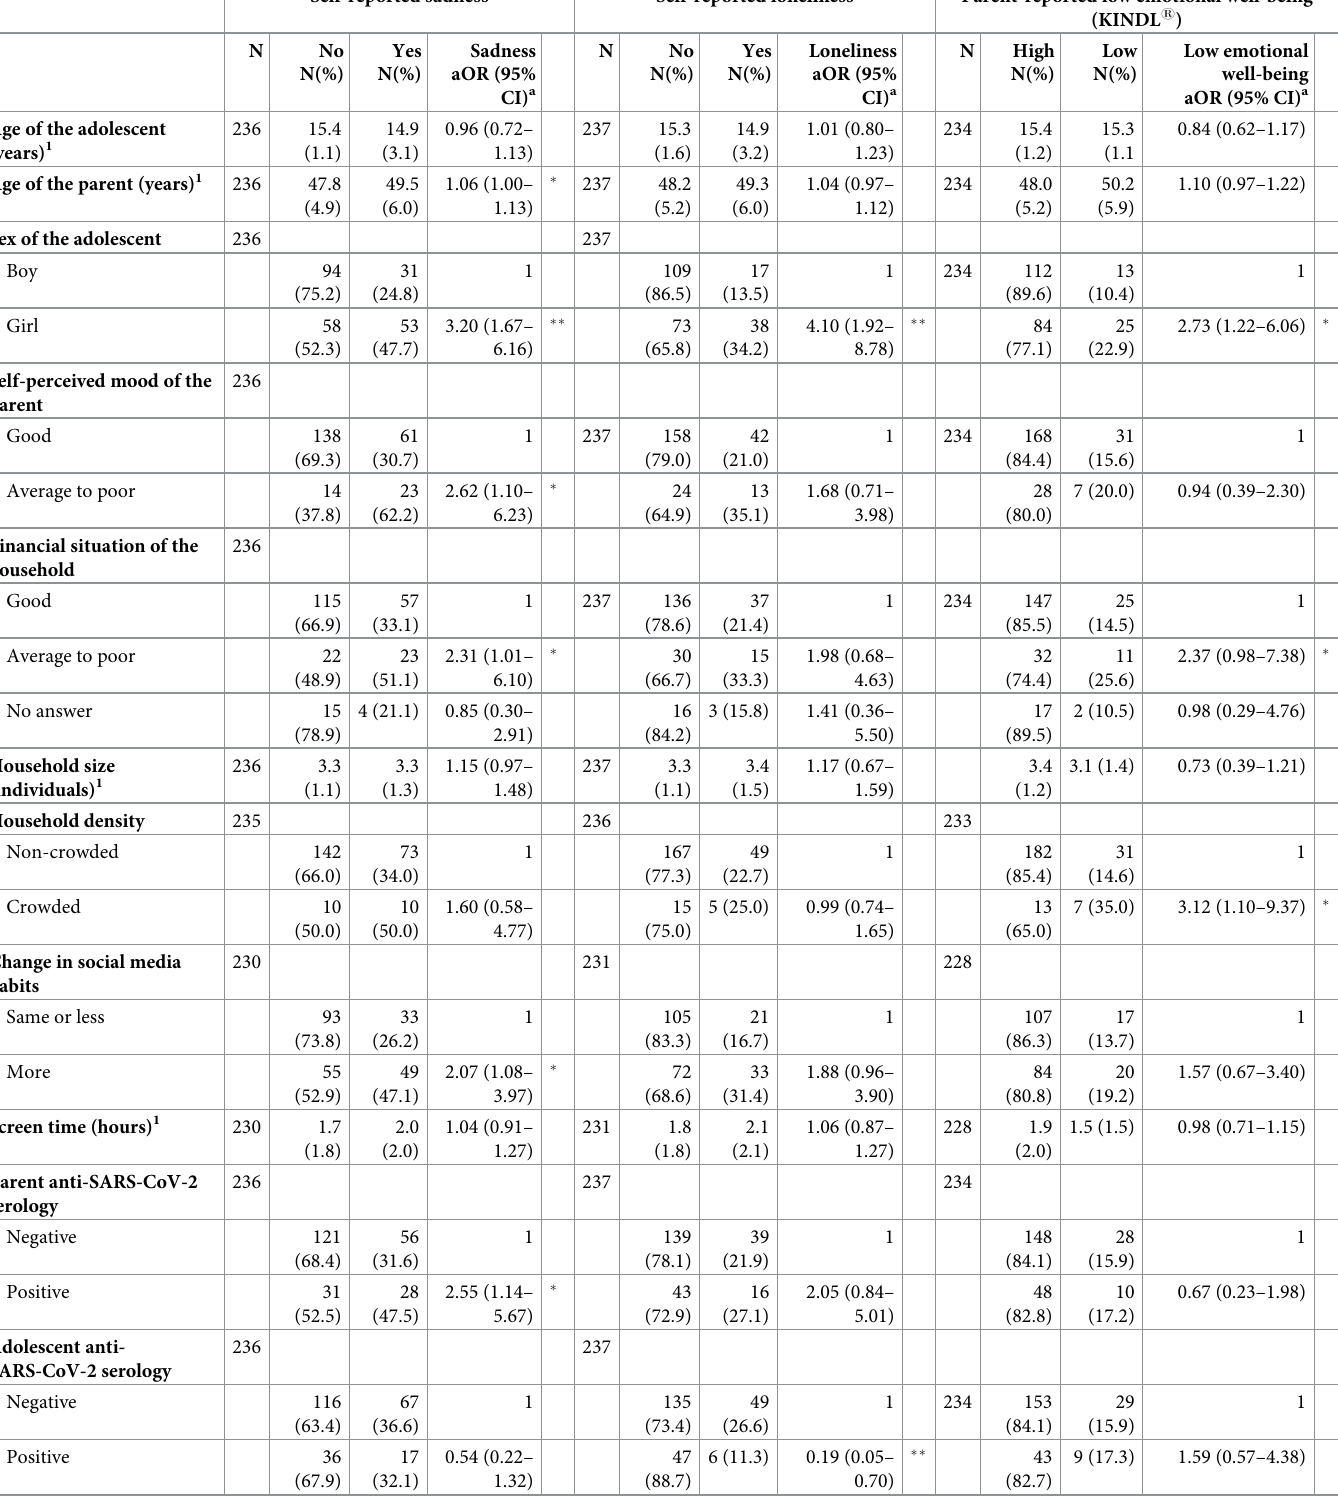
Table 3. Risk factors for adolescents’ self-reported loneliness and sadness, and parent-reported low emotional well-being. Self-reported